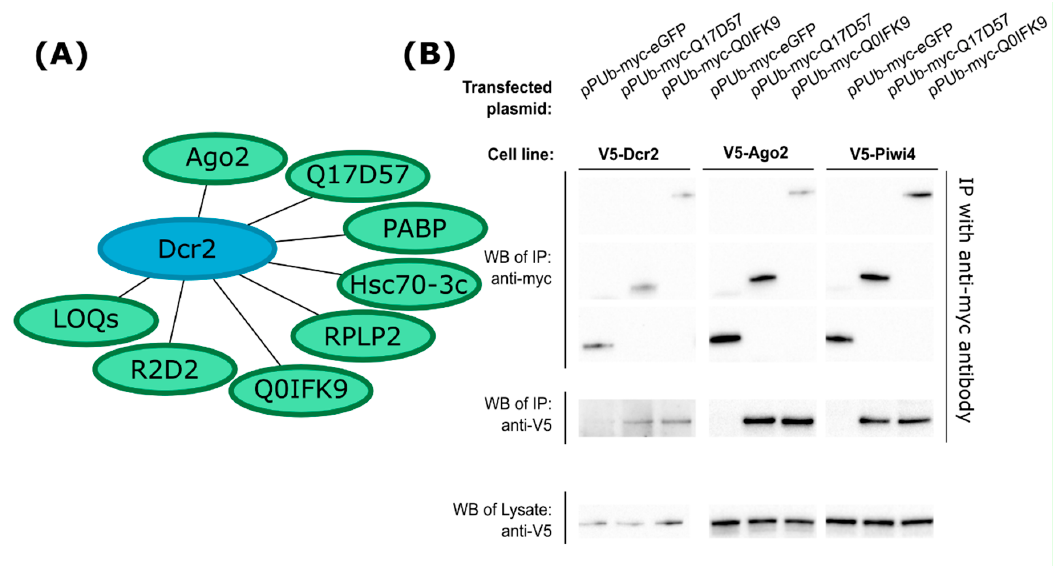
Figure 1. Summary of Dicer 2 (Dcr2) interactions and confirmation of interactions by immunoprecipitation (IP). ( A ) Protein associated (directly or indirectly) with Dcr2 from Aag2 cells; samples were obtained by IP followed by mass-spectrometry and database search. ( B ) V5-tagged protein-expressing Aag2 cell lines were transfected with myc-tagged protein expression constructs. At 48 h p.t., cell lysates were subjected to IP with anti-myc antibodies. In Western blot (WB) analysis, immunoprecipitated samples were probed for the presence of V5 and myc tags, and cell lysates were analyzed for V5 tagged proteins Dcr2, Ago2, and Piwi4; data shown are representative of three independent experiments. LOQs, Loquacious; PABP, poly(A)-binding protein; RPLP2, ribosomal protein lateral stalk subunit P2; Ago2, Argonaute 2; Dcr2, Dicer 2;